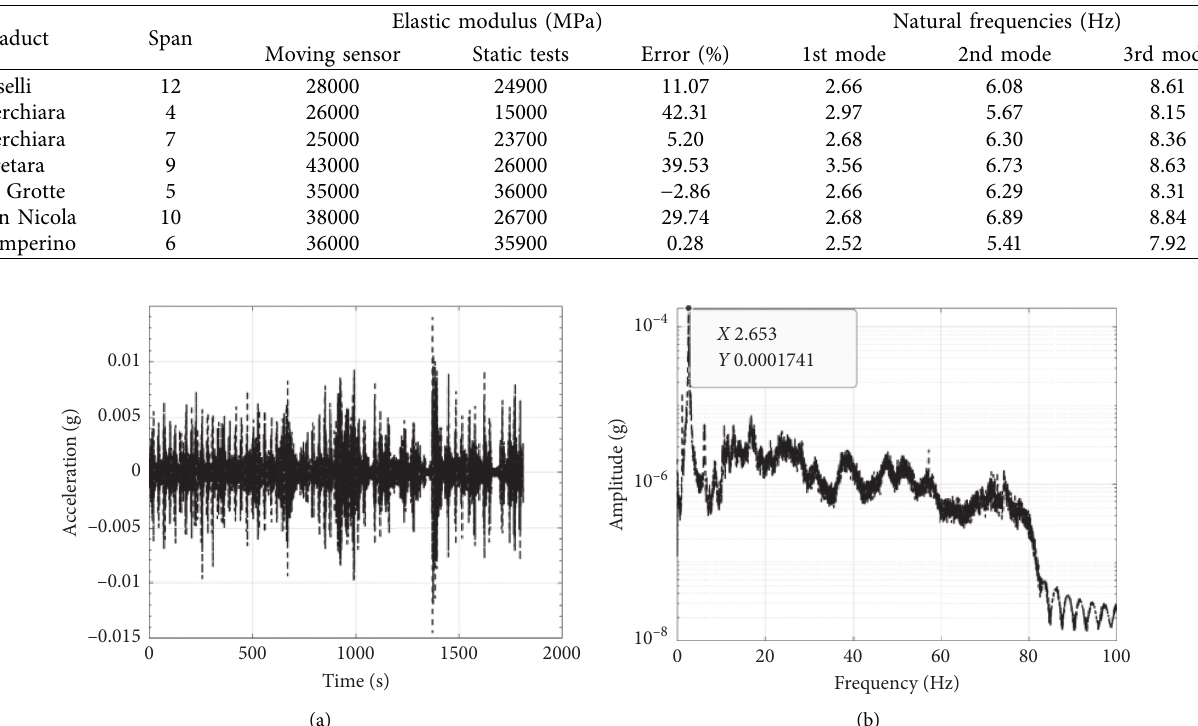
Figure 2: (a) Acceleration time series acquired by a fixed sensor by the midspan of the Le Grotte viaduct: the peaks correspond to the passage of the vehicle. (b) Fast Fourier transform of the signal in (a).